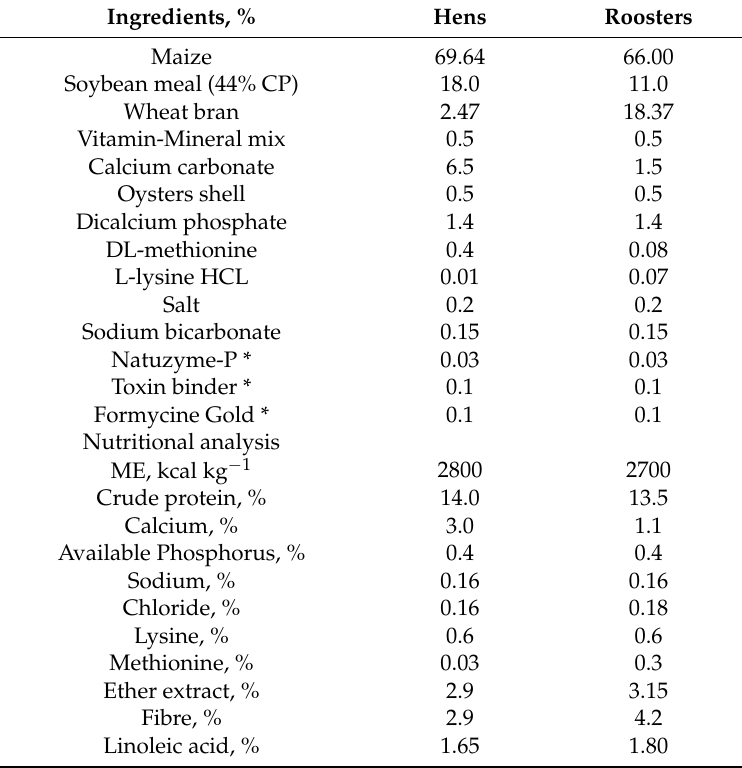
Table 1. Experimental basal-diet fed to broiler breeder hens and roosters. Ingredients, % Hens Roosters